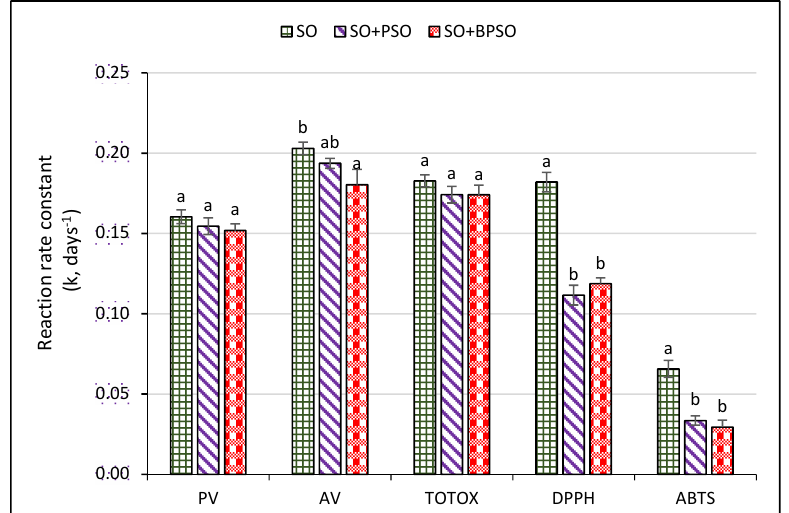
Figure 2. Reaction rate constants (k, day − 1 ) of oxidation indices (PV, AV, and TOTOX) and radical scavenging capacity (DPPH and ABTS assays) in SO and oil blends (85:15 w / w ) during accelerated storage following a first-order kinetic model. Within the same parameter, bars with different letters are significantly different ( p < 0.05). SO—sunflower oil, PSO—pomegranate seed oil from unblanched seeds, BPSO—pomegranate seed oil from blanched seeds, TOTOX—total oxidation value, AV— ρ -Anisidine value, PV—peroxide value DPPH—2. 2- diphenyl-1-picryl hydrazyl, ABTS—2, 2'-azinobis (3-ethylbenzothiazoline-6-sulfonic acid).